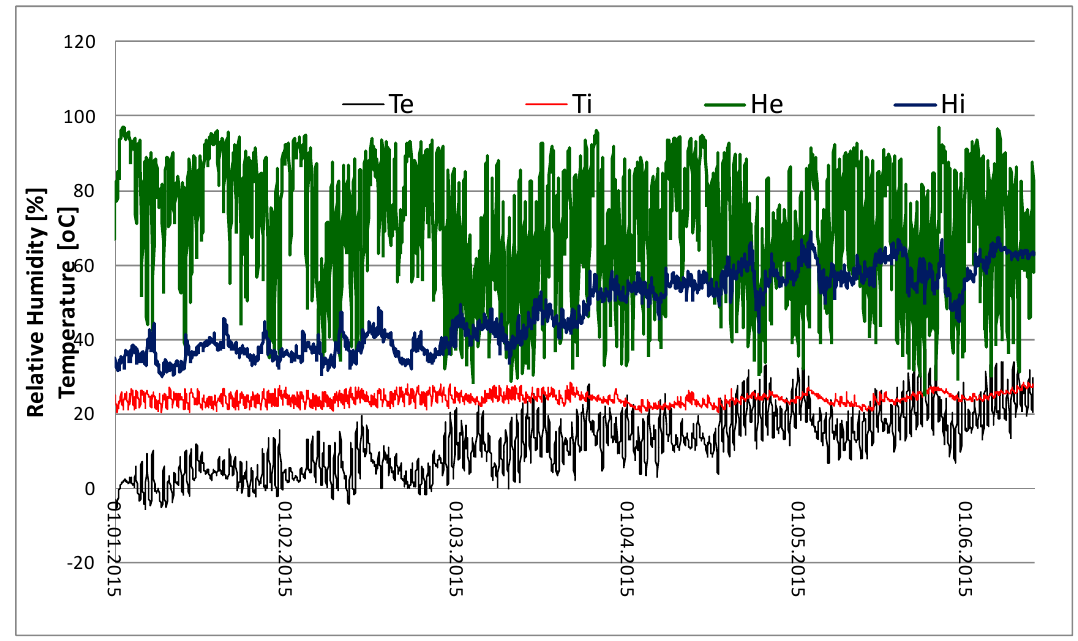
Figure 5. Changes of temperature and relative humidity for the environments surrounding the envelope (index i—internal environment, index e—external environment).